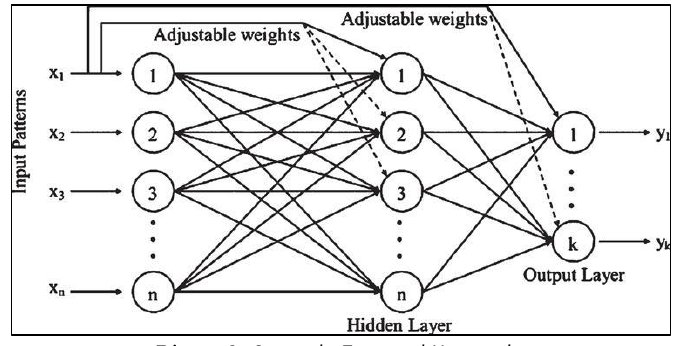
Figure 2: Cascade Forward Network.